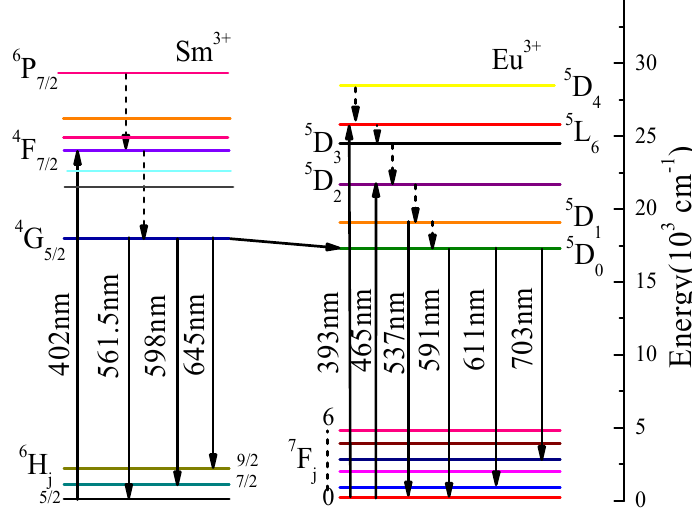
Figure 7. The energy transfer pathway between Eu 3+ and Sm 3+ in NaLa(MoO 4 ) 2 .